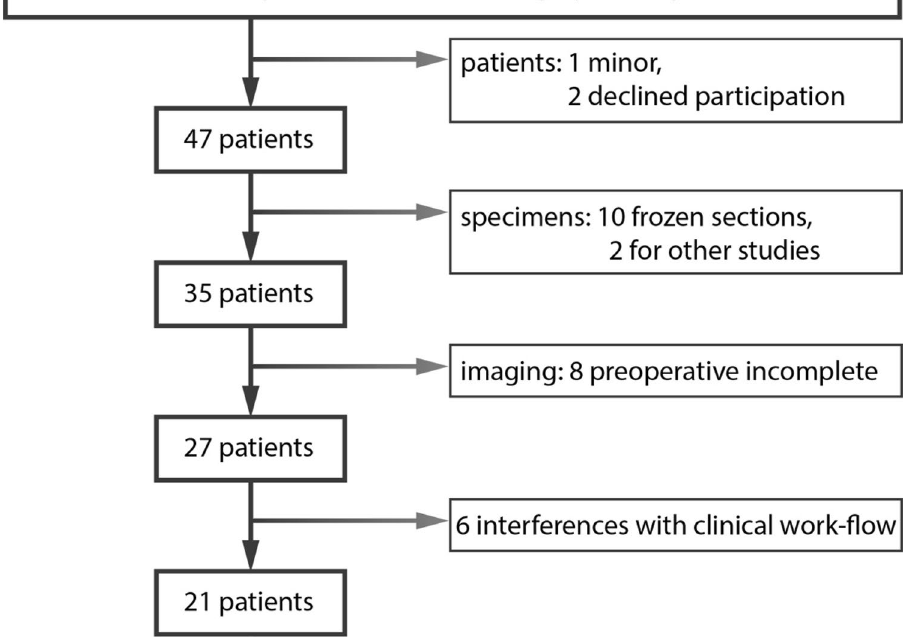
Figure 1. Eligible patients and exclusion criteria resulting in the participation of 21